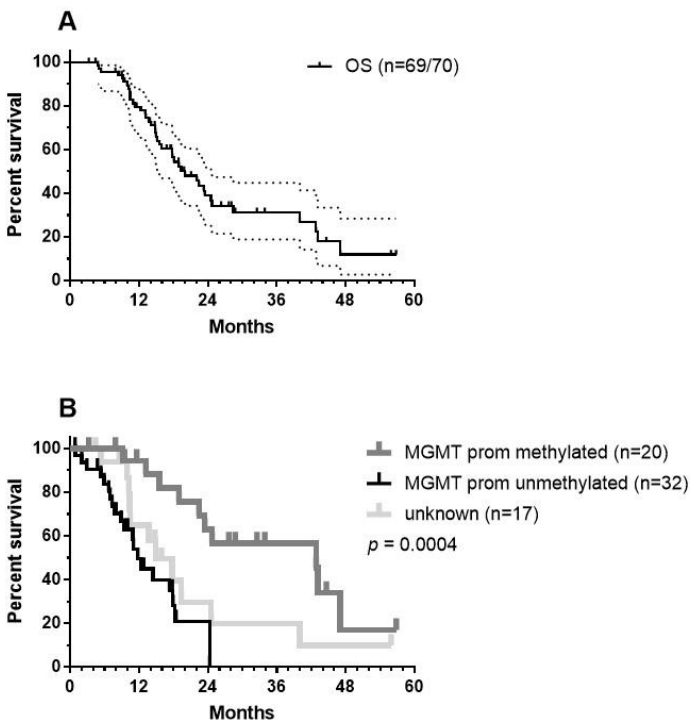
Figure 5. OS data: ( A ) OS data of the total patient group (CI95% values are shown). One patient out of 70 was lost during the follow up period and ( B ) the patient group was divided according to MGMT promotor methylation status—methylated (grey), unmethylated (black), data not registered (light grey). The p -values show significance using the Log-rank (Mantel–Cox) test. For 16 patients, local therapy (neurosurgery, radiochemotherapy) was followed by IMI (Group 1). ICD therapy (the combination of IV bolus injections of NDV together with mEHT [19]) integrated into the TMZm chemotherapy cycles followed by IO-Vac ® DC vaccines and maintenance ICD therapy was given to 46 patients (Group 2). Eight patients started with IMI after the last TMZ maintenance chemotherapy cycle (Group 3). The OS data were significantly different for the three treatment groups: 13.08 months for group 1, 22.46 months for group 2, and undefined for group 3 (median follow-up of surviving patients: 28.59 months, range 26.3–55.9 months; Figure 6A). The latter likely points to favorable selection of a small group of patients who experienced no events until after the end of the maintenance chemotherapy and profited from subsequent IMI treatment. The median OS of the patients with unmethylated MGMT promotor status was 11.25 months for group 1 ( n = 7) and 18.07 months for group 2 ( n = 21), with a 2-year OS of 0% in group 1 versus 17.18% (CI95% +31.65, − 15.86) in group 2 (Figure 6B, log-rank test: p = 0.0273). The median OS of the patients with methylated MGMT promotor status was 42.85 months for group 2 ( n = 15) with a 2-year OS of 66.66% (CI95%: +19.3, − 32.96). There were only three patients in group 1 who had a tumor with MGMT promotor methylation status. Within treatment group 2, the differences in the OS curve due to MGMT promotor methylation status were significant (Figure 6C, Log-rank test: p =